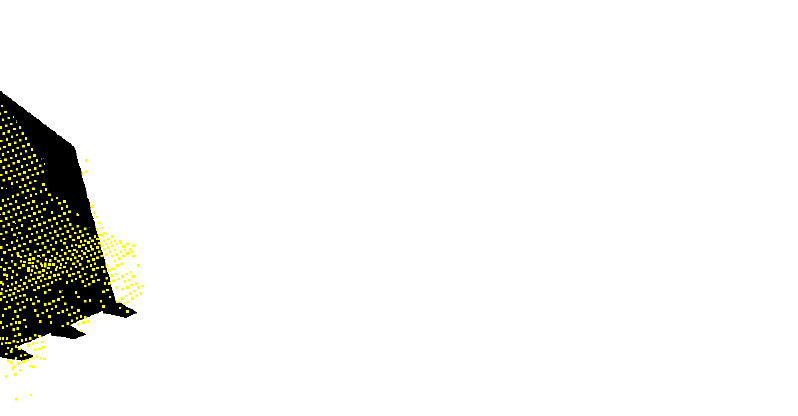
Figure 12. ( a ) Bucket volume image; ( b ) bucket point cloud .